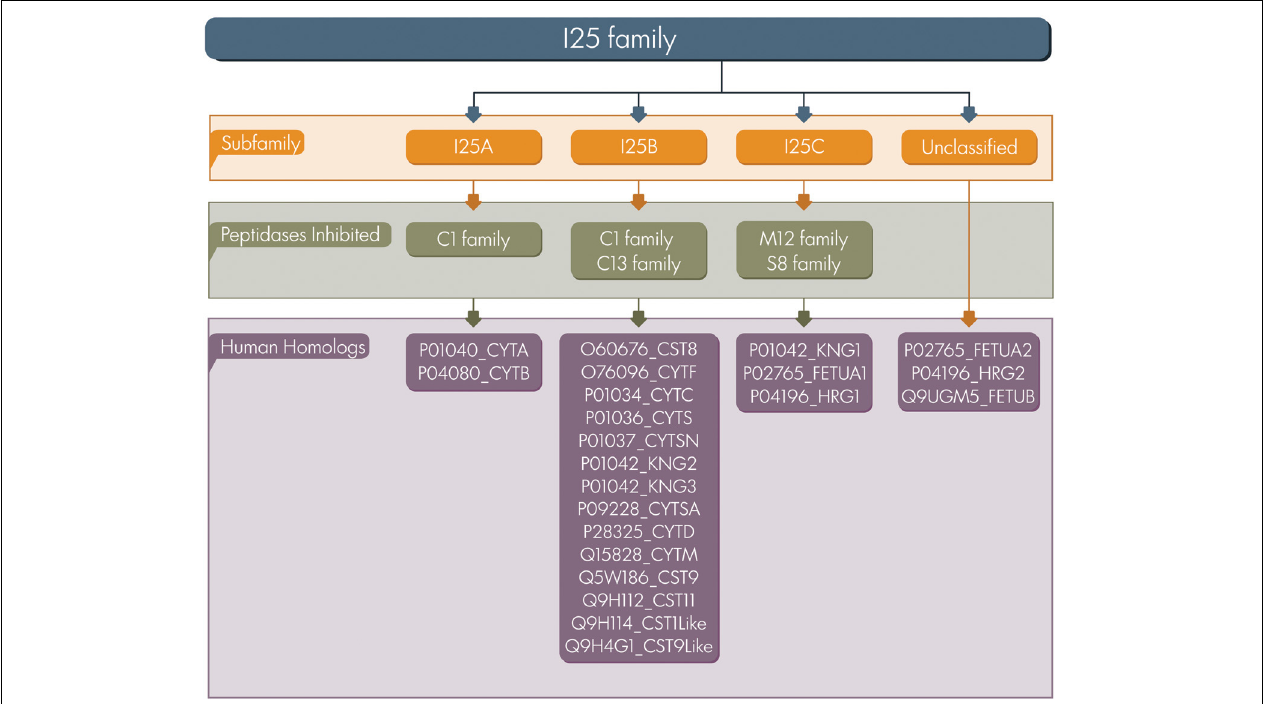
FIGURE 1 | Cystatin classification. The I25 family is classified in three subfamilies (I25A–C) according to MEROPS. Several family members remain unclassified. UniProt accession numbers of human homologs are listed.